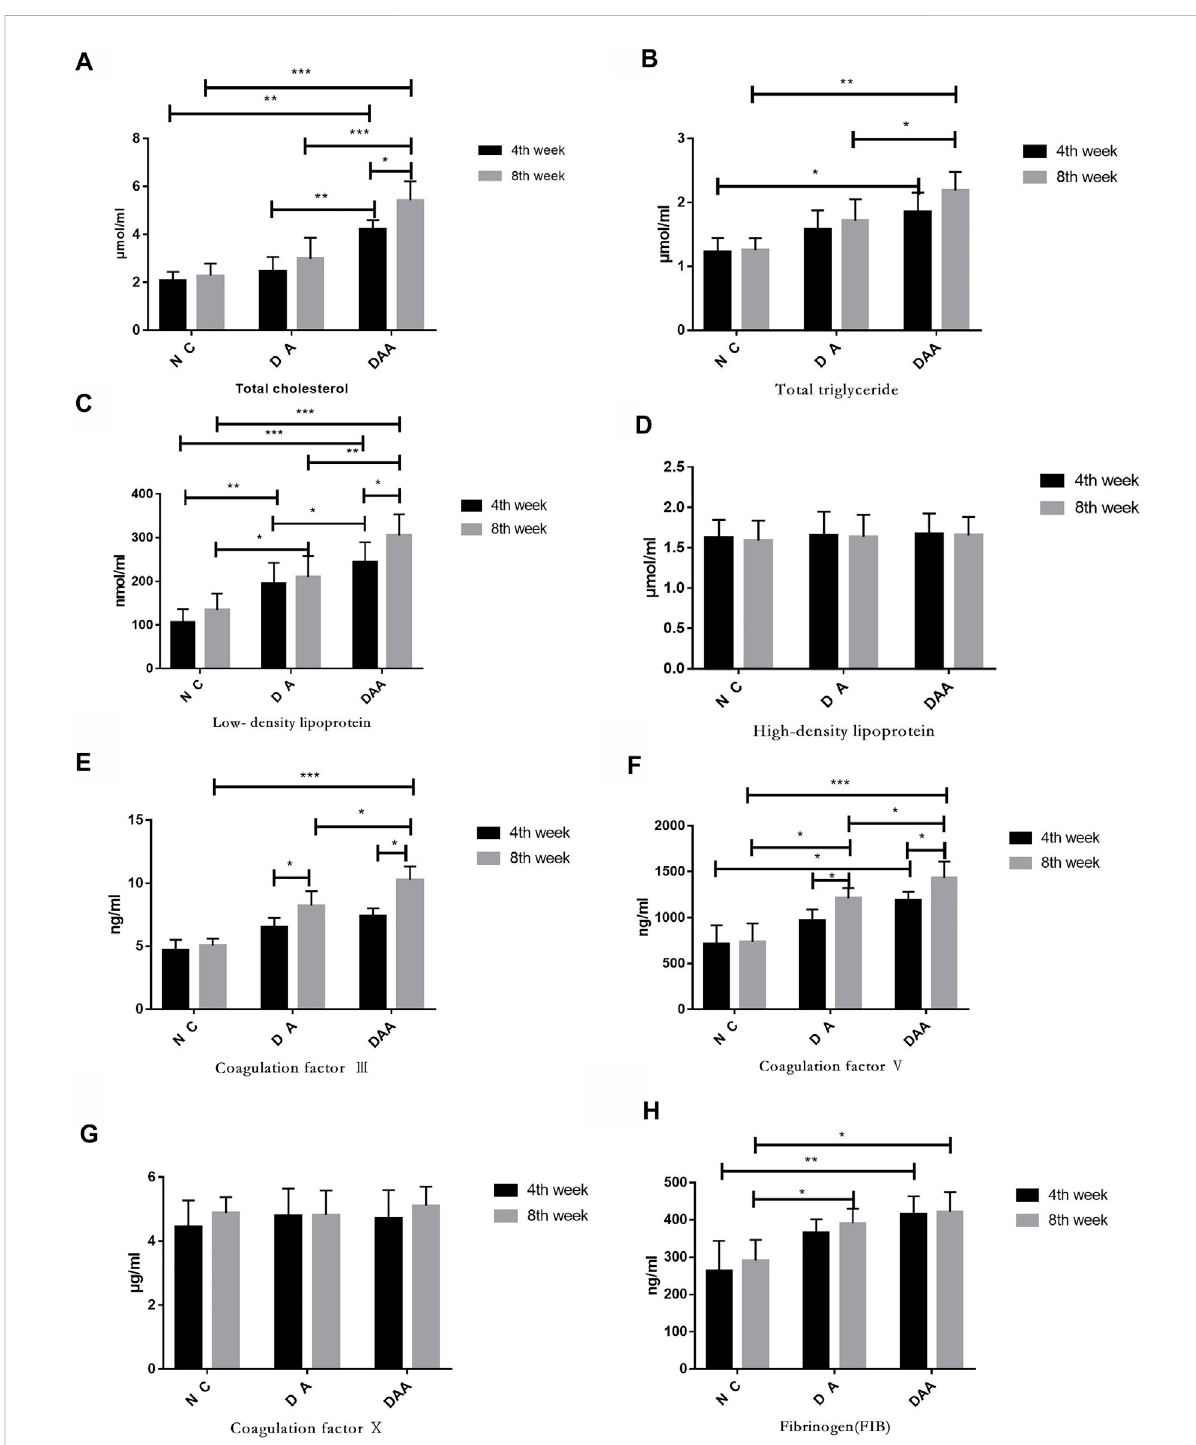
FIGURE 2 Effects of Ang II combined with ASP on lipids and clotting factors in mice with steroid-induced femoral head osteonecrosis. (A) Total cholesterol. (B) Total glycerol triglycerides. (C) Low-density lipoprotein. (D) High-density lipoprotein. There was no signi fi cant difference between thegroups. (E) Clotting factorIII. (F) Clotting factorV. (G) ClottingfactorVI. (H) Fibrinogen.Therewasnosigni fi cantdifferencebetweenthegroups.* indicates p < 0.05; ** indicates p < 0.01; and *** indicates p <